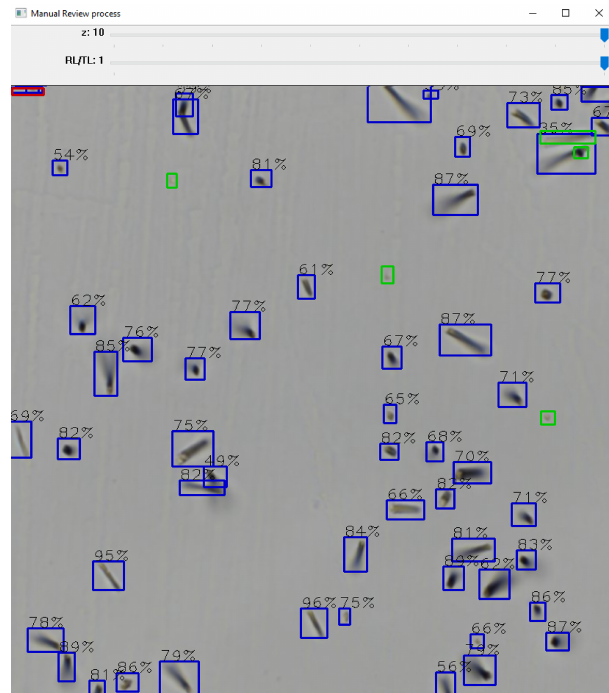
Figure 2. Fission track recognition in muscovite (external detec- tor). Blue squares indicate automatically recognized semi-tracks. The percentage displayed above every blue box indicates the confi- dence score for that particular group of pixels to be recognized as a semi-track. The small fraction of unrecognized tracks (“false nega- tives”) is manually indicated using green squares. Red squares indi- cate erroneously indicated tracks (“false positives”). The two track bars above the image indicate the possibility of comparing different focal levels or change between reflected and transmitted